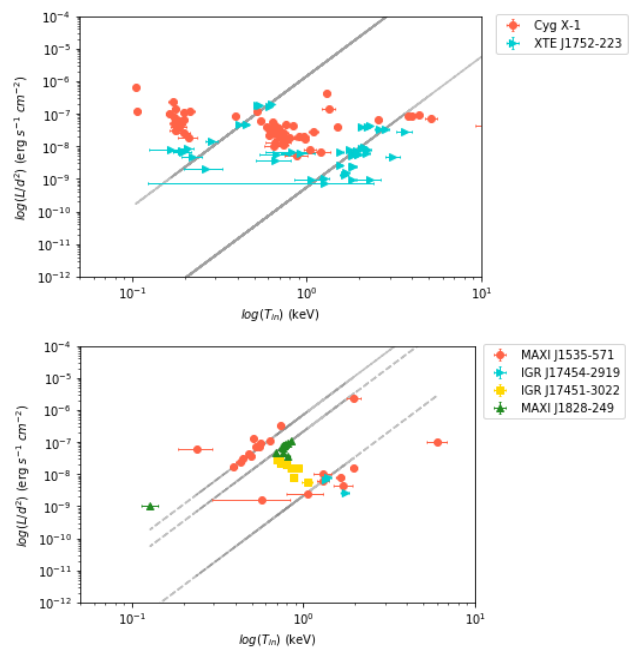
Fig. 8. The innermost disk temperature and luminosity relations. The lines are the L/d 2 as a function of T 4